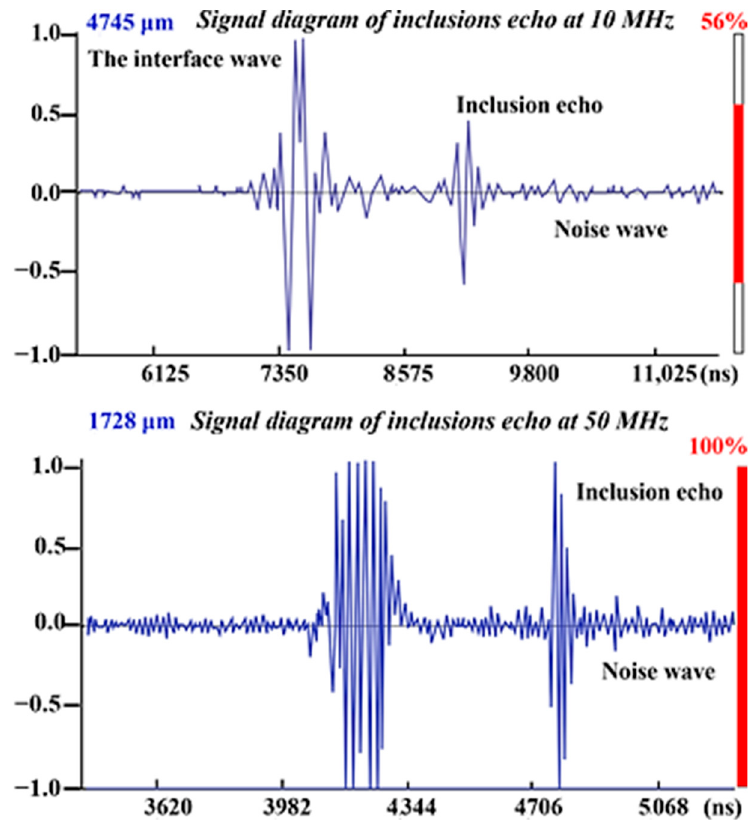
Figure 6. A longitudinal wave scanning signal of the largest inclusion under different frequency probes (10 MHz and 50 MHz).